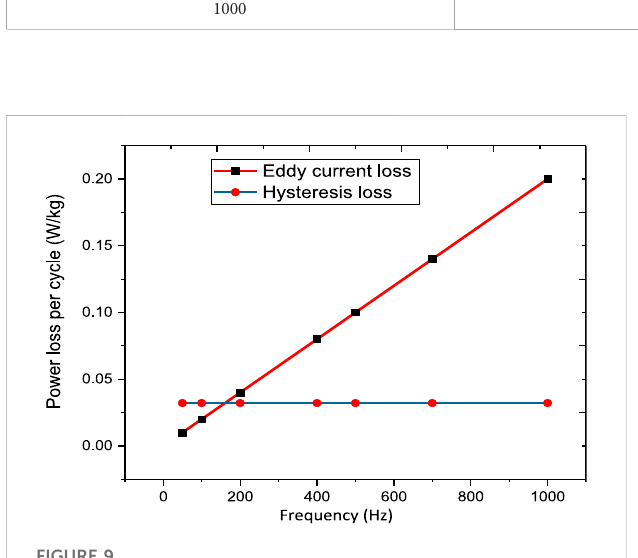
FIGURE 9 Eddy current and hysteresis loss per cycle versus frequency.